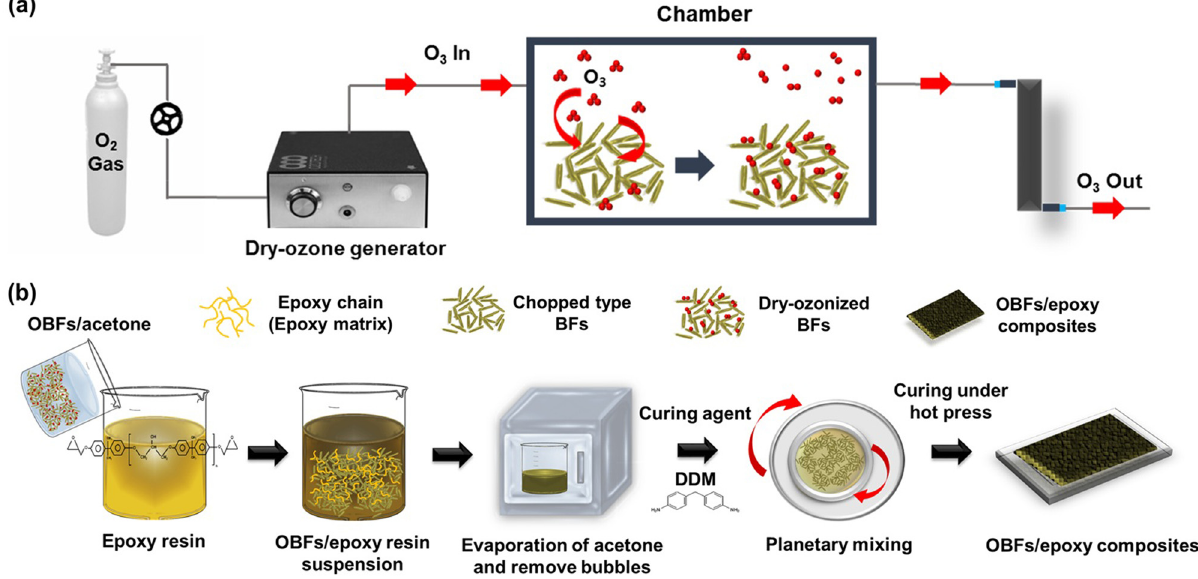
Figure 1: Schematic representation of OBFs/epoxy composites: ( a ) dry - ozone treatment of BFs and ( b ) composite preparation